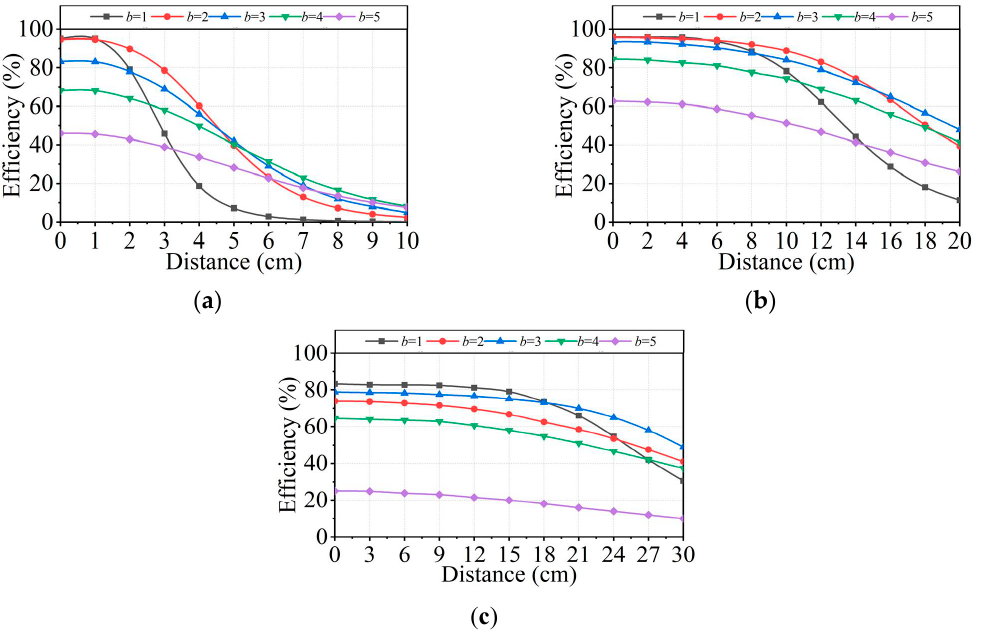
Figure 6. PTE curves with different values of b : ( a ) R A = 2–10 cm, R B = 2 cm; ( b ) R A = 5–25 cm, R B = 5 cm; ( c ) R A = 10–50 cm, R B = 10 cm.